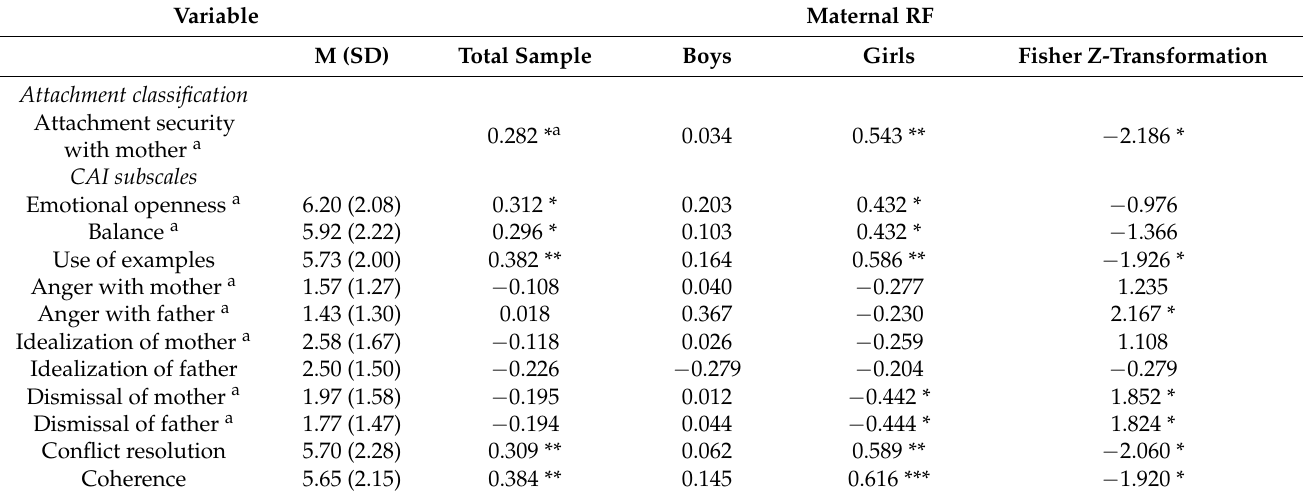
Table 2. Relationship between maternal RF and child attachment variables.